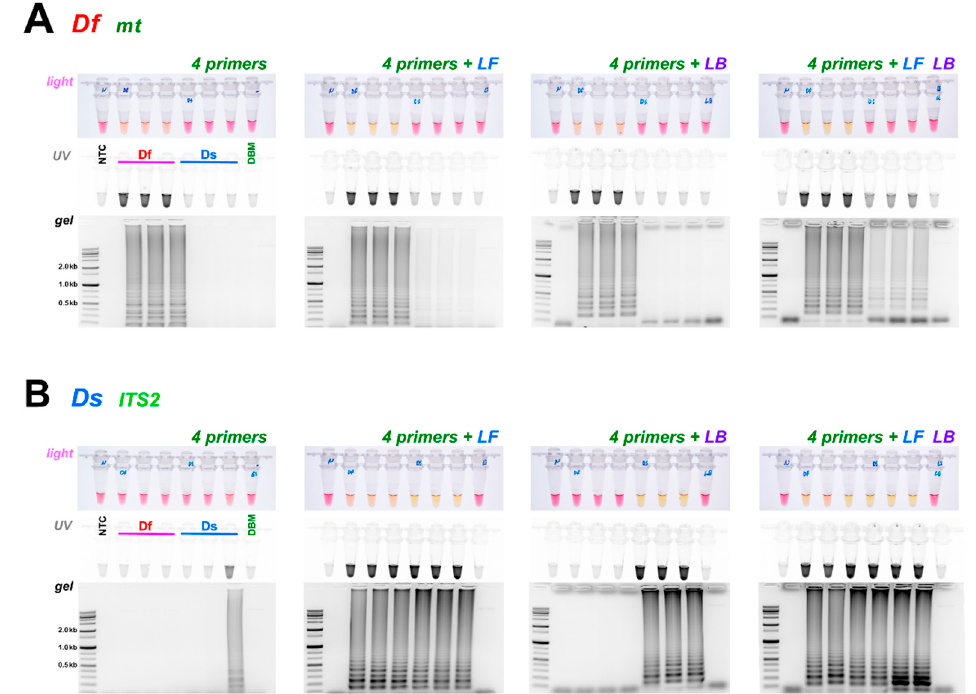
Figure 4. LAMP assay results with four primers (F3, B3, FIP, and BIP) and additional loop primers, loop backward (LB) and loop forward (LF), of ( A ) mt-based Df and ( B ) ITS-based Ds. The LAMP assay was performed at 63 °C for 35 min under visible light, ultraviolet light with SYBR Green, and gel electrophoresis. The abbreviations are the same as those described in Figure 3. Df, Diadegma fenestrale ; Ds, Diadegma semiclausum ; LAMP, loop-mediated isothermal amplification.